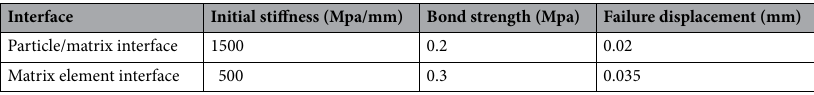
Table 5. Mechanical parameters of interface.